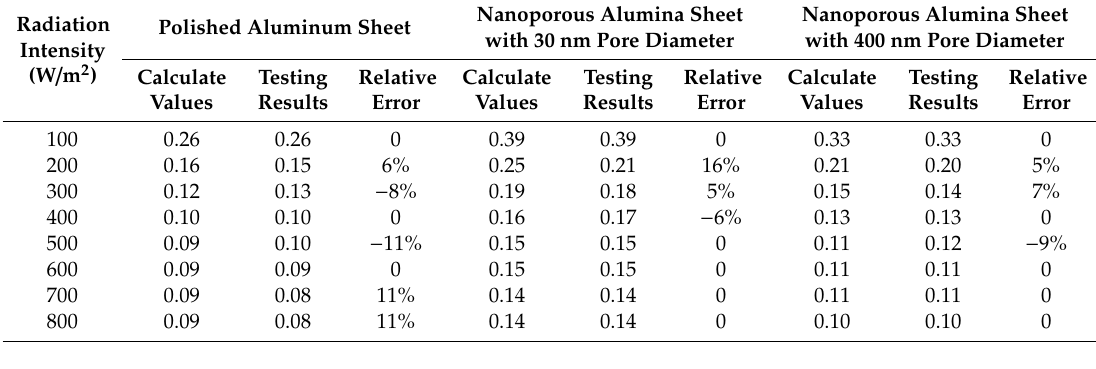
Table 3. Relative error of the calculated and testing absorptivity for the testing rigs operated under di ff erent radiation intensity.